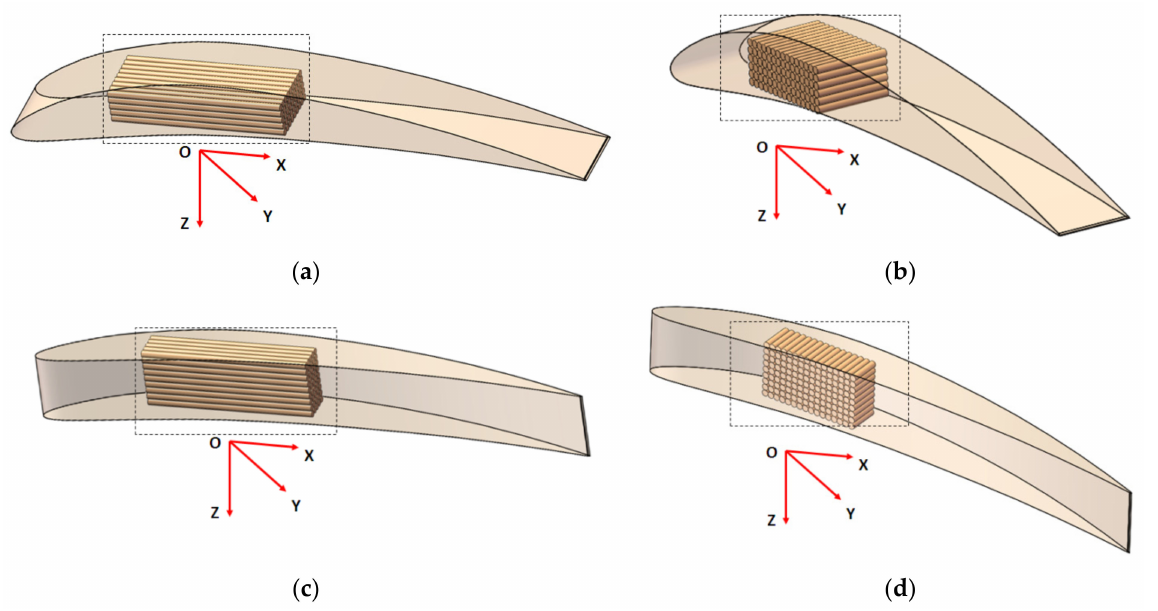
Figure 16. VS-SW specimens with partial views indicating the layers of cylinders for the different print orientations: ( a ) matte XY; ( b ) matte YX; ( c ) glossy XY; ( d ) glossy YX.